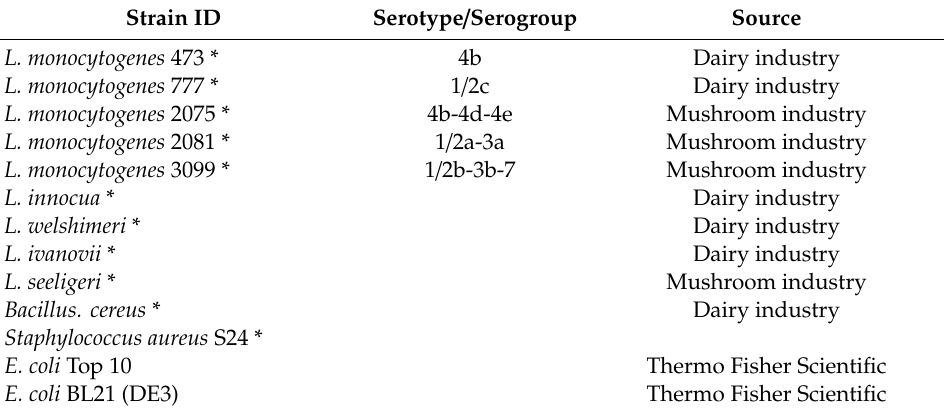
Table 1. Strains used in this